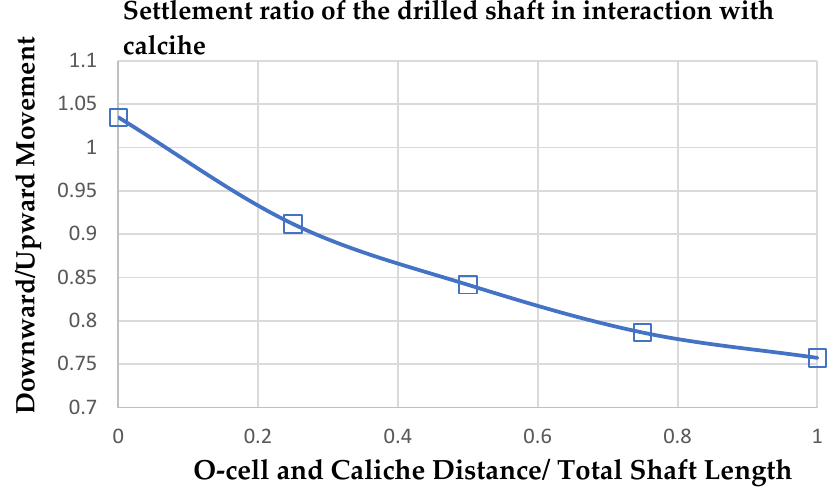
Figure 6. Comparison of Upward and Downward Settlement based on the O-cell location in the drilled shaft.